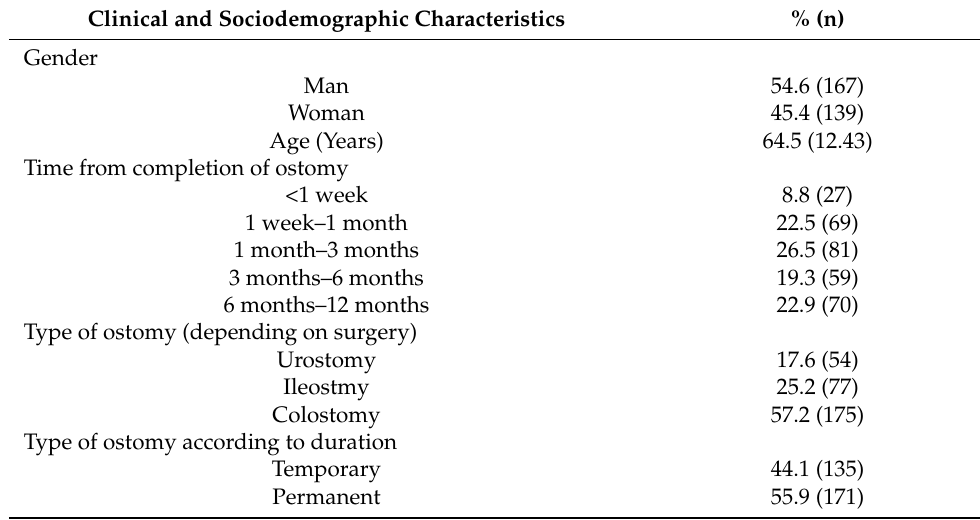
Table 1. Clinical and sociodemographic characteristics of study